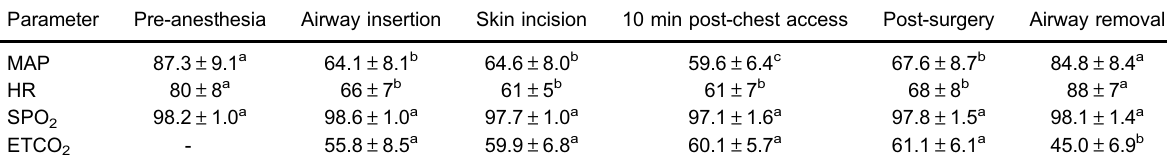
Table 2. Comparison of hemodynamic parameters and end-tidal partial pressure of carbon dioxide among different time points.